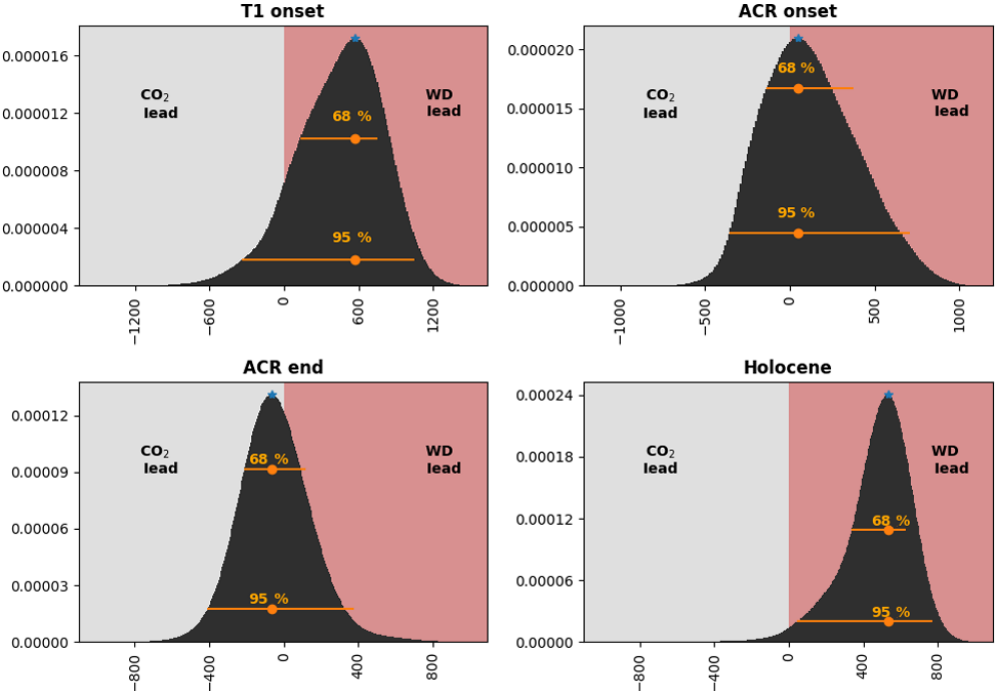
Figure 6. Probability density ρ ( y axis, normalized) of an ATS lead ( x -axes, in years) at each of the selected change point intervals (noted on subfigures). Negative x -axis values indicate a CO 2 lead. The maximum probability lead/lag and 68% / 95% central probability intervals are indicated by the orange dot and lines on each